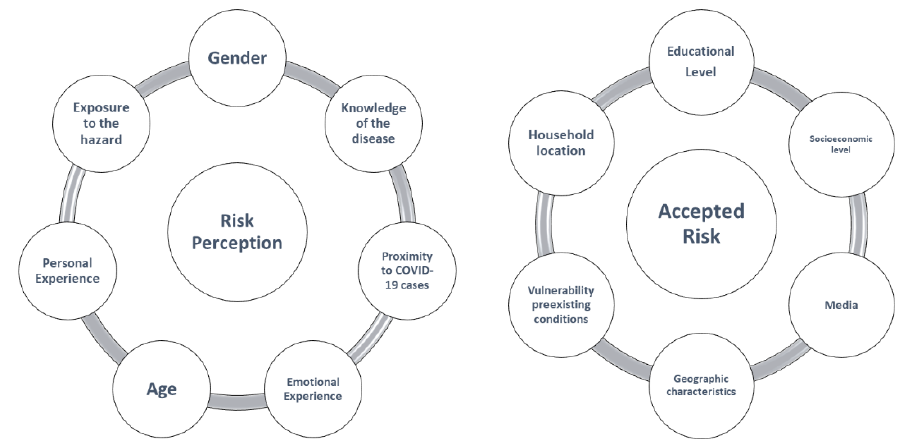
Figure 2. Factors influencing people’s perception of risk.